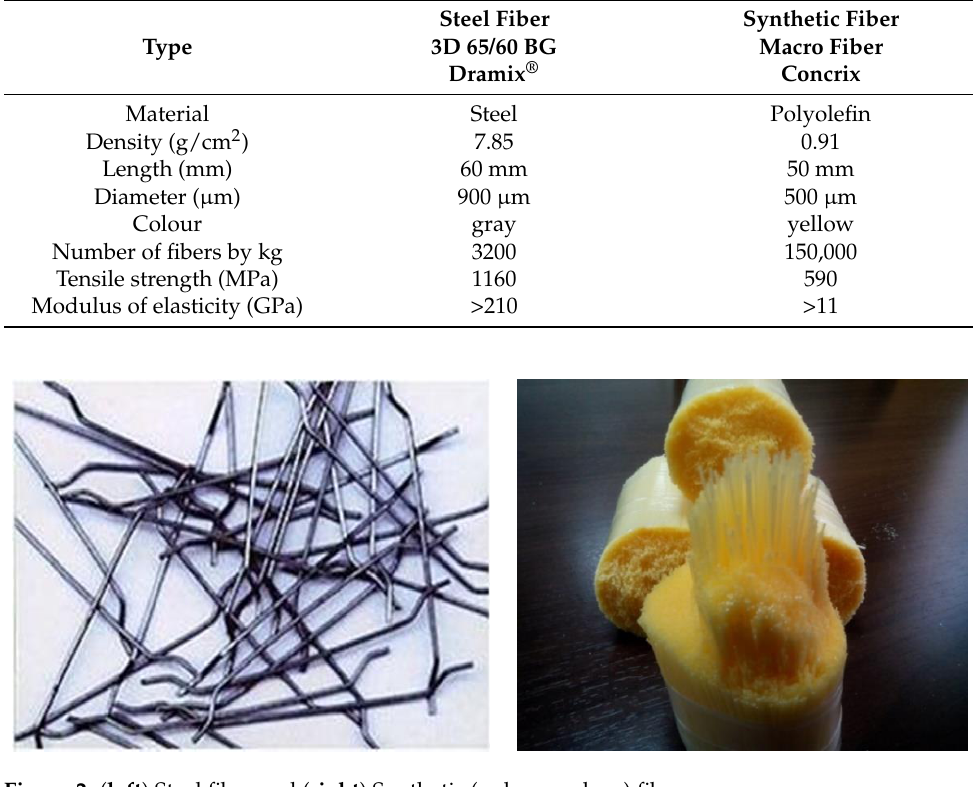
Figure 1. Grading curves of sand, quartz coarse aggregate, and expanded clay LWA.